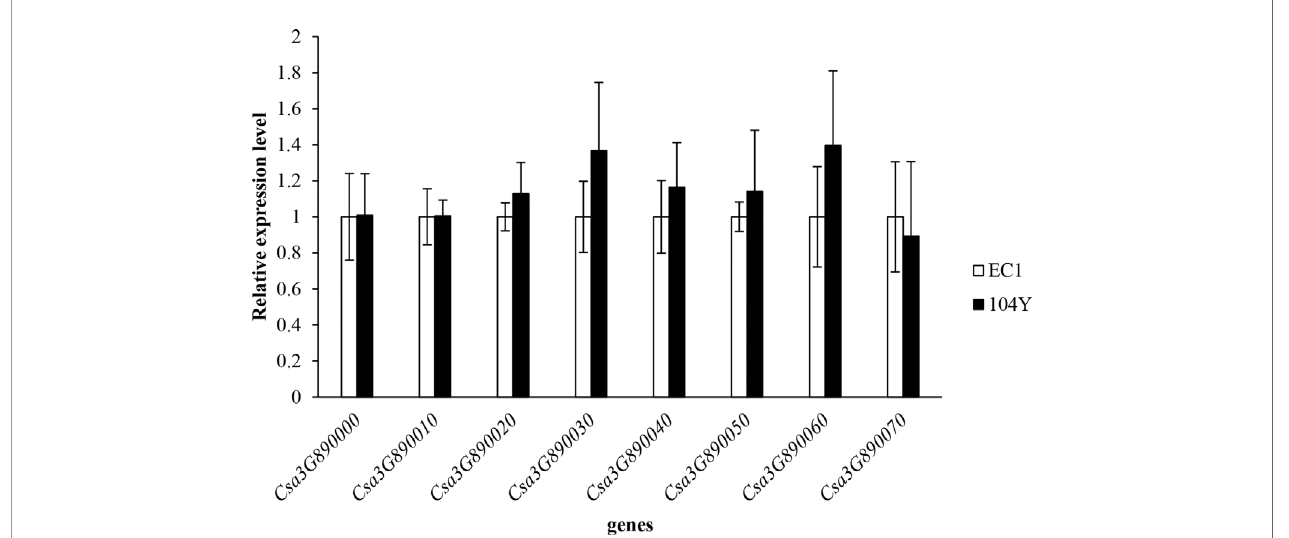
FIGURE 6 | Relative expression levels of eight candidate genes in the fi rst true leaf of EC1 and 104Y by qRT-PCR analysis. Data were displayed using the CsActin gene as an internal control with three biological and three technical replicates. Values are the mean ±